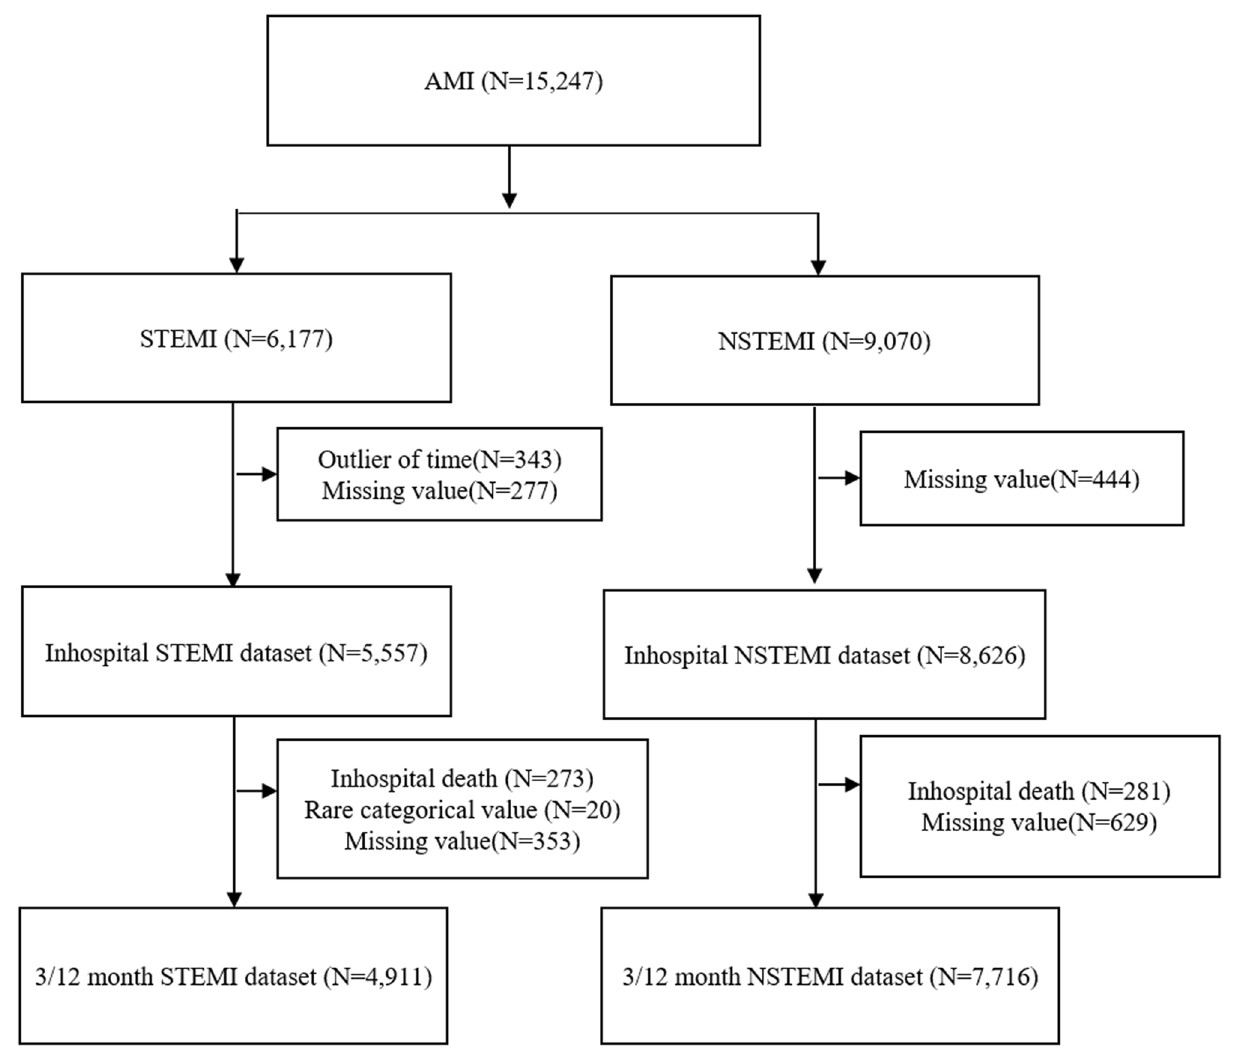
Figure 3. Flowchart of study inclusion. AMI, Acute Myocardial Infarction; STEMI, ST-segment elevation Myocardial Infarction; NSTEMI, Non-ST-segment elevation Myocardial